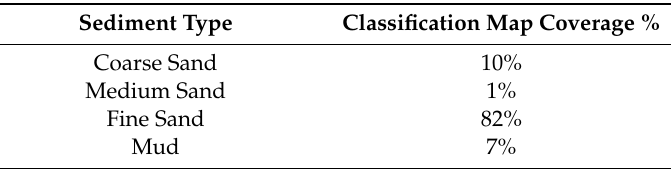
Table 1. Surficial sediment distribution by class type based on the 2014–2015 habitat mapping Table1. expedition.